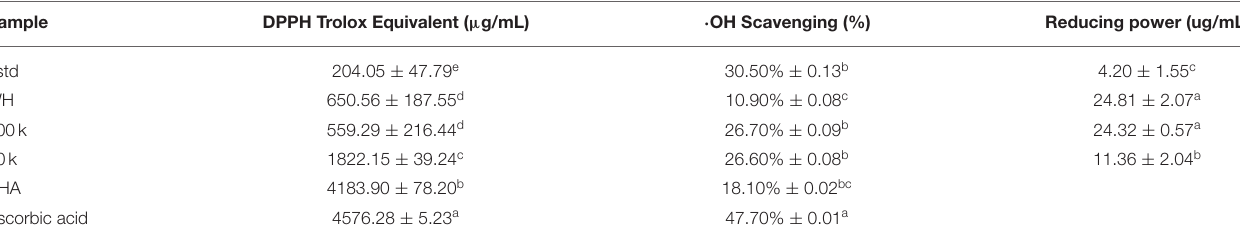
TABLE 2 | Antioxidant activities and reducing power of Fstd, WH, 300k, 10k, ascorbic acid and